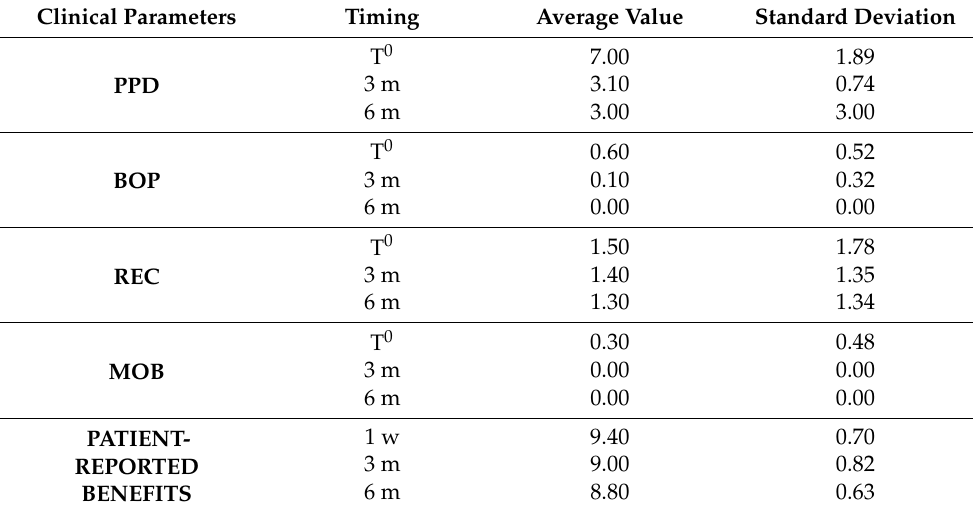
Table 2. Clinical parameters were measured at baseline (T 0 ), after 3 months, and after 6 months in peri-implantitis sites treated with Aladent ® .